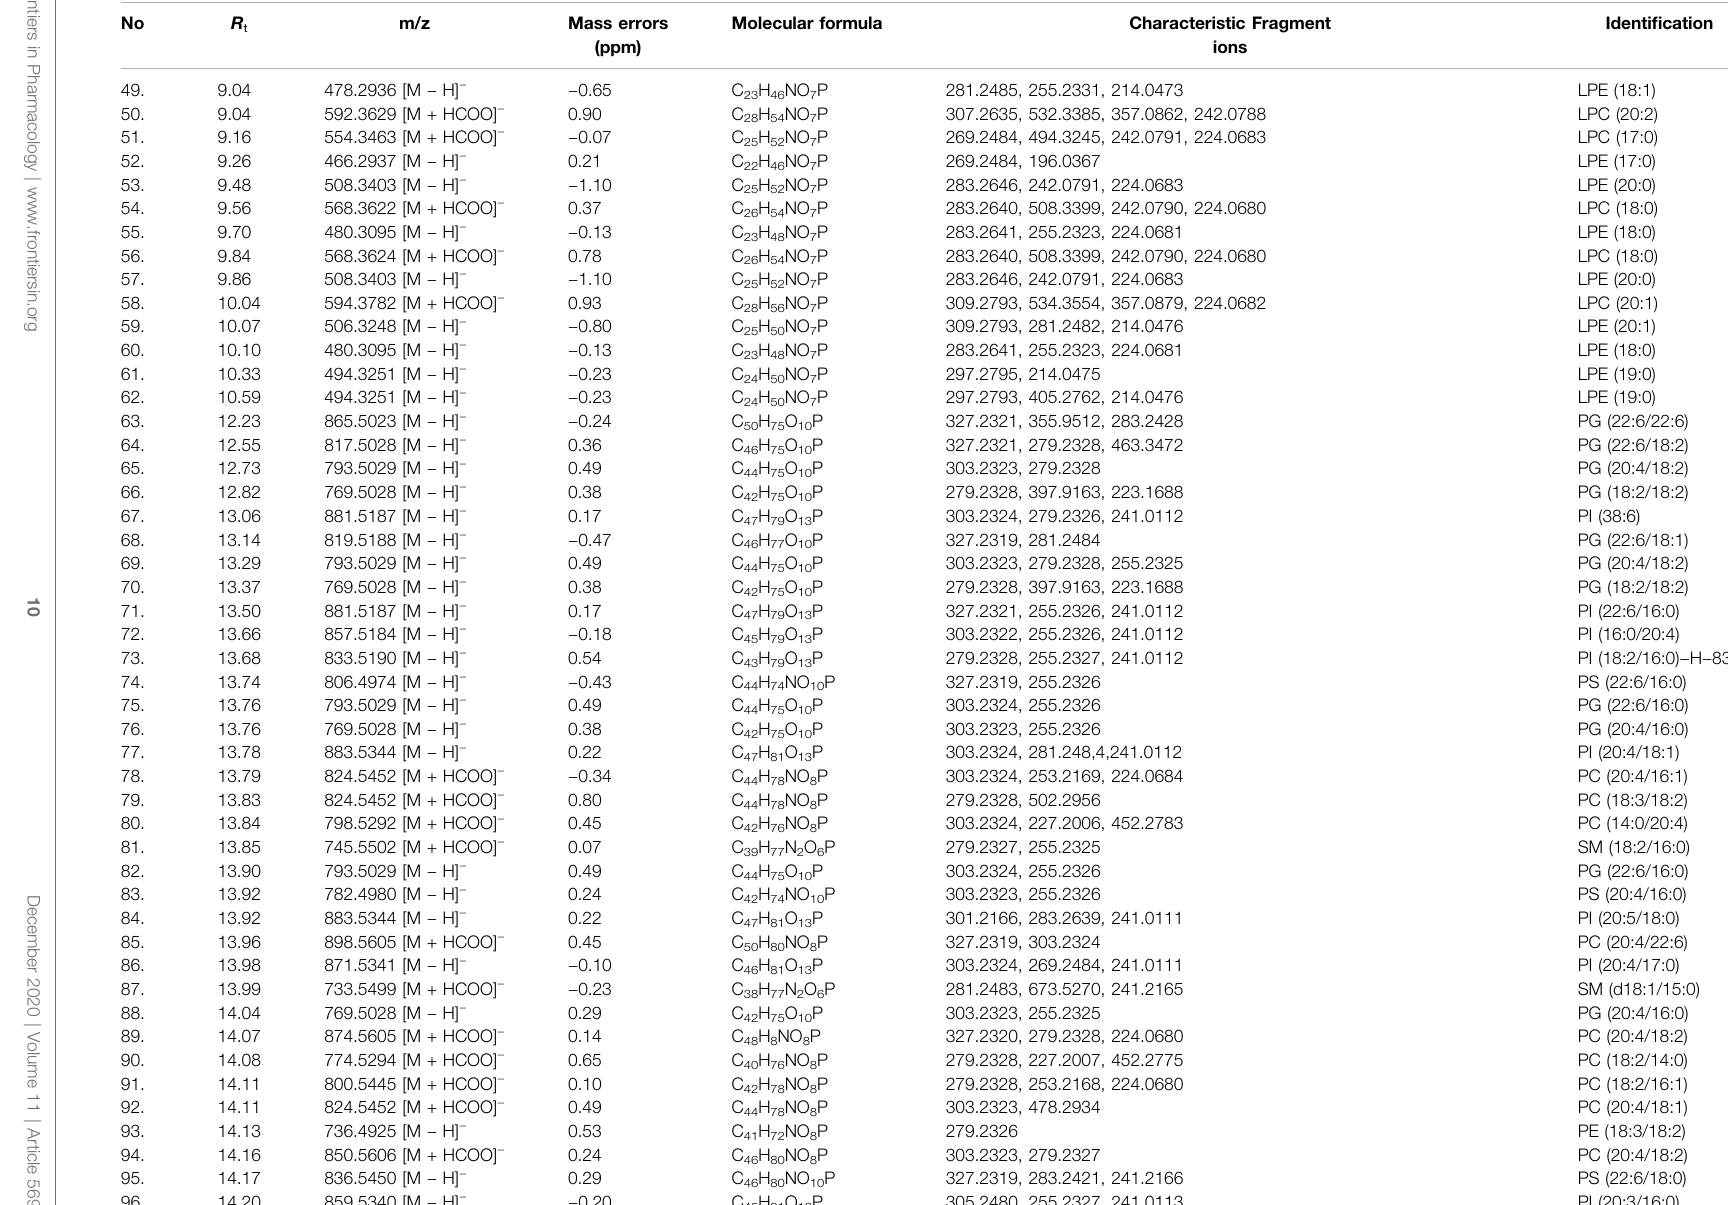
TABLE 2 | ( Continued ) The detected and tentatively identi fi ed lipid molecules in the rat